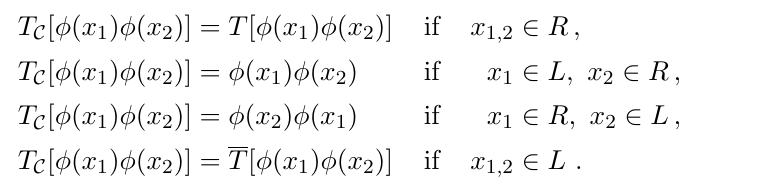
Figure 5 . Time folded contour used for and the labels R and L are used to distinguish the two contours by the direction in which time